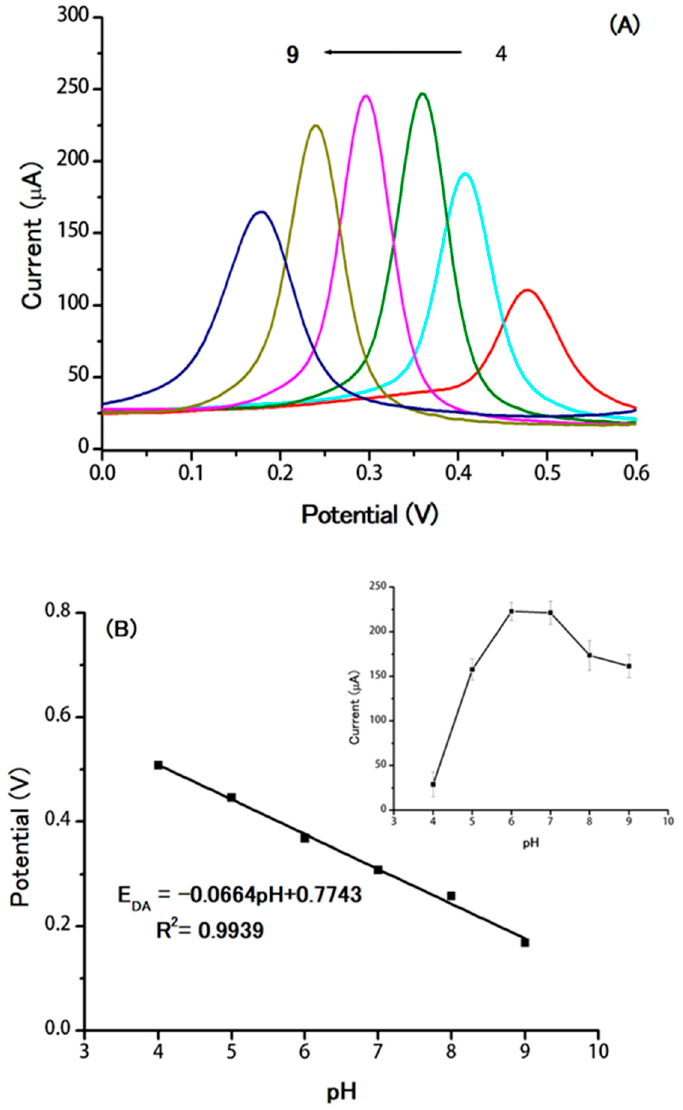
Figure 6. ( A ) Di ff erential pulse voltammograms obtained at the supramolecular electrochemical sensor (TBABr / SDS ··· AuNPs / GO / GCE) in the range of pH 4.0 to 9.0 in 0.1 M PBS containing 0.80 µ M DA at a scan rate of 50 mV / s. ( B ) The linear regression equation between potential and pH. Inset: the plot of anodic current of DA versus pH